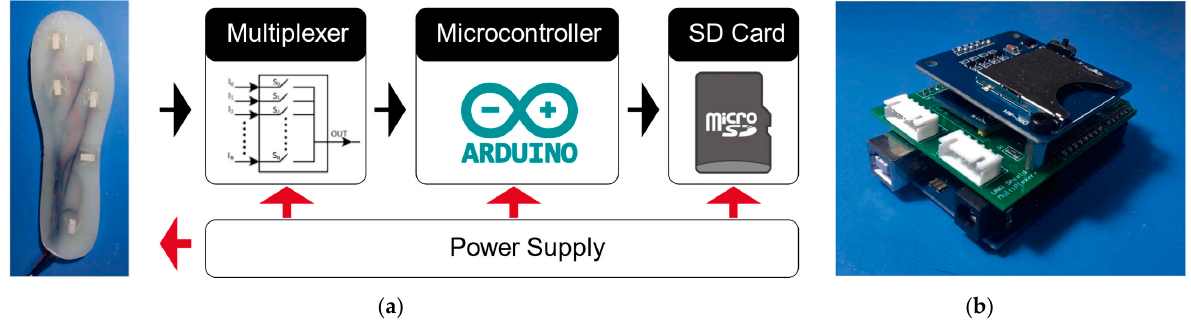
Figure 8. Circuit system diagram ( a ) and Arduino UNO expansion integrated circuit board ( b).